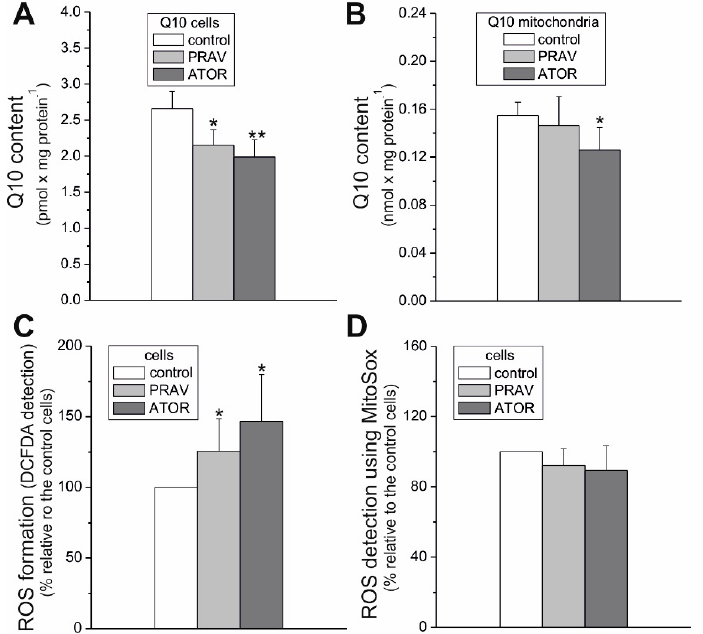
Figure 4. Cellular and mitochondrial Q10 content and ROS formation in endothelial cells grown for 6 days in the presence of 100 nM PRAV or 100 nM ATOR or under control conditions. Q10 concentration in endothelial cells ( A ) and mitochondria ( B ). Measurements of total cellular ROS using CM-H 2 DCFDA ( C ) and ROS formation with the MitoSox probe ( D ). Mean ± SD; n = 6-9. p < 0.05 (*), p < 0.01 (**), comparison vs. control values.